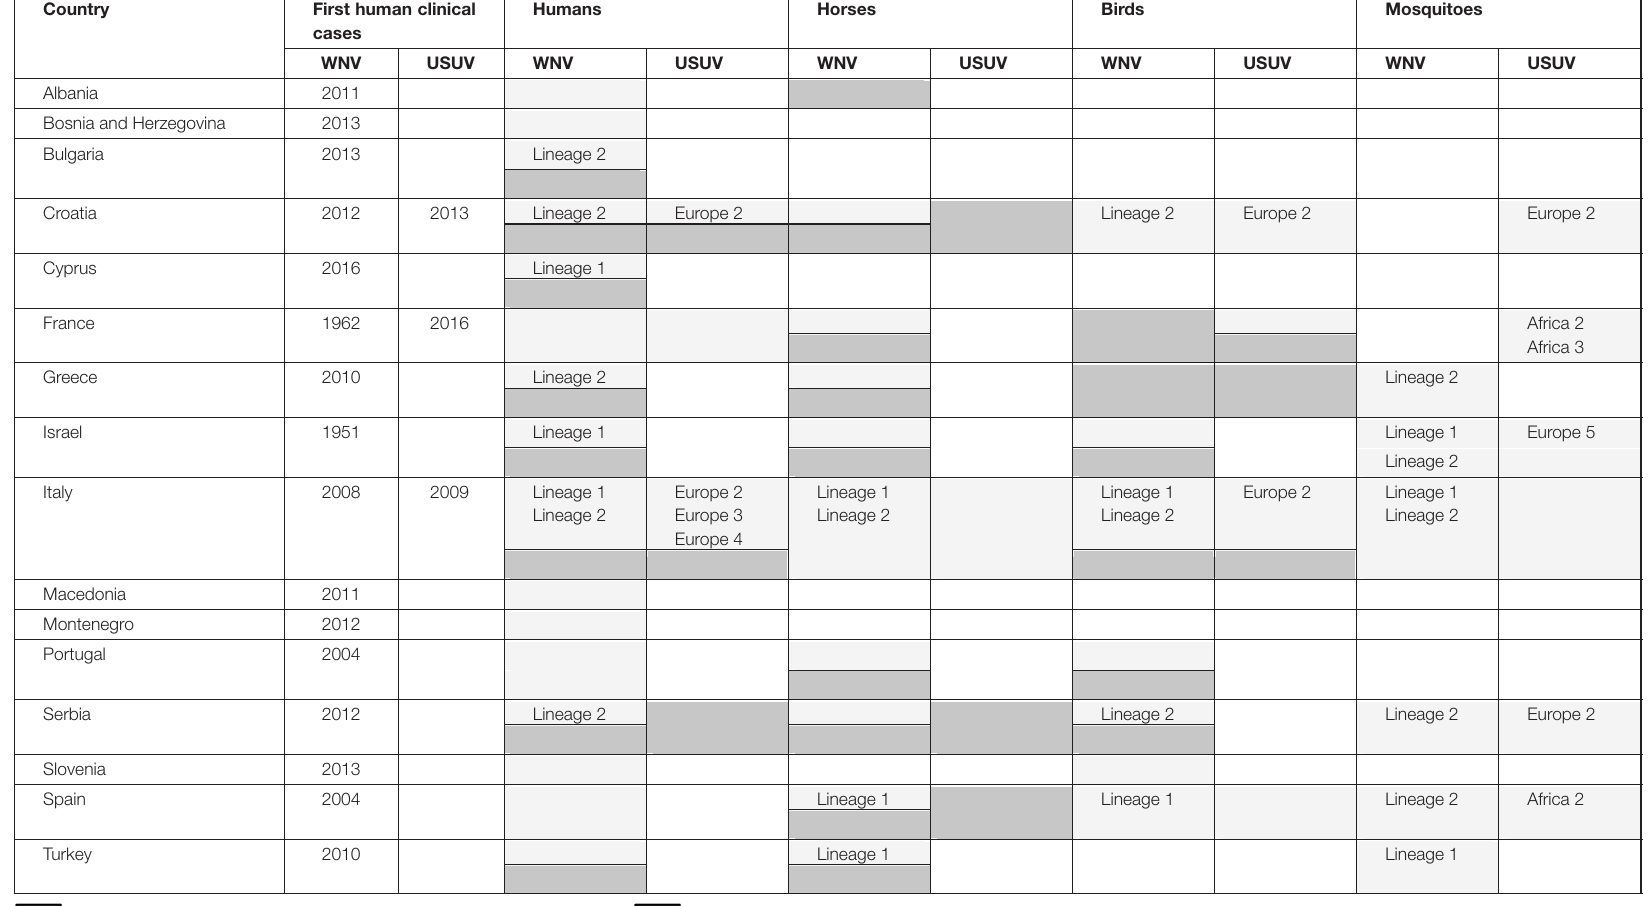
TABLE 1 | Summary of West Nile and Usutu virus infections in Southern Europe.